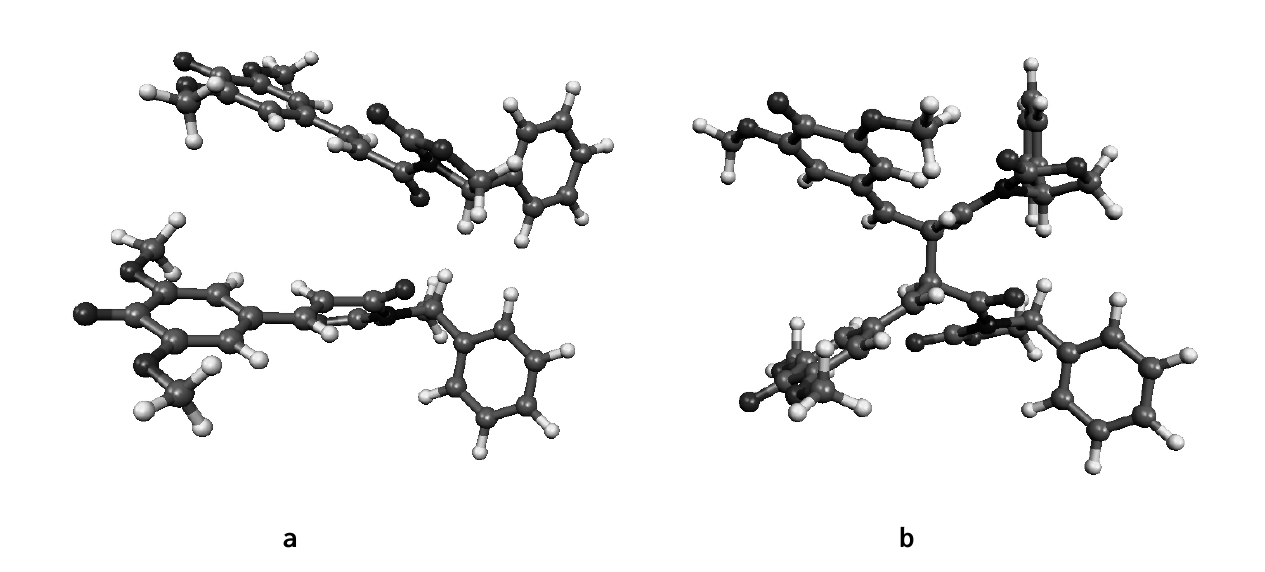
Figure 4b. Molecular geometry of the van der Waals pre-reactive complex with the monomers at the si-si face ( a ), and the corresponding bisquinomethide product ( b ).